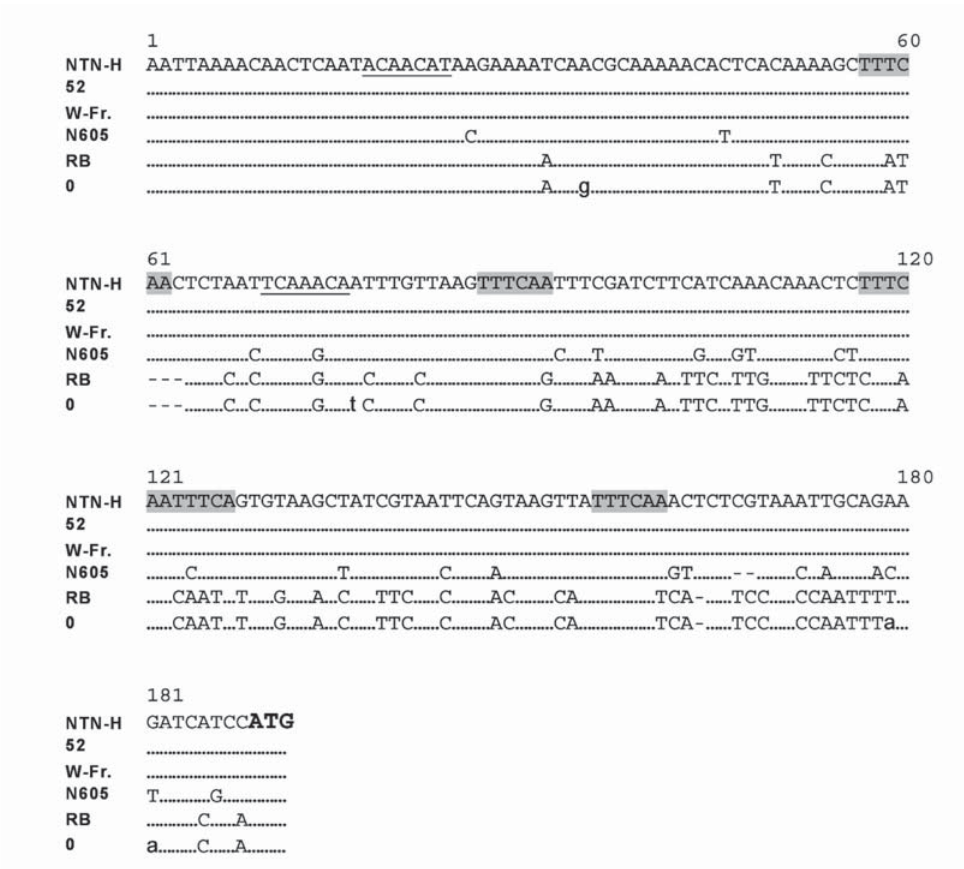
Fig. 1. The 5’-UTR nucleotide sequences of PVY isolates. The 5’-end region of several PVY isolates (as indicated in the figure) was amplified by PCR (with primers I and III) yielding a 950 nt long product, cloned, sequenced and the 5’-UTR nucleotide sequences were aligned. Identical nucleotides are marked with dots, modified nucleotides with letters, and a deletion with a dash. The upper and lower sequences of PVY NTN -H (Thole et al., 1993) and PVY O (Singh and Singh, 1996) were used as references (accession No. M95491 and U09509 respectively). Nucleotide modifica- tions unique to PVY O are indicated with small letters. The a- and b-boxes at positions 70 and 162 respectively (Turpen, 1989) are